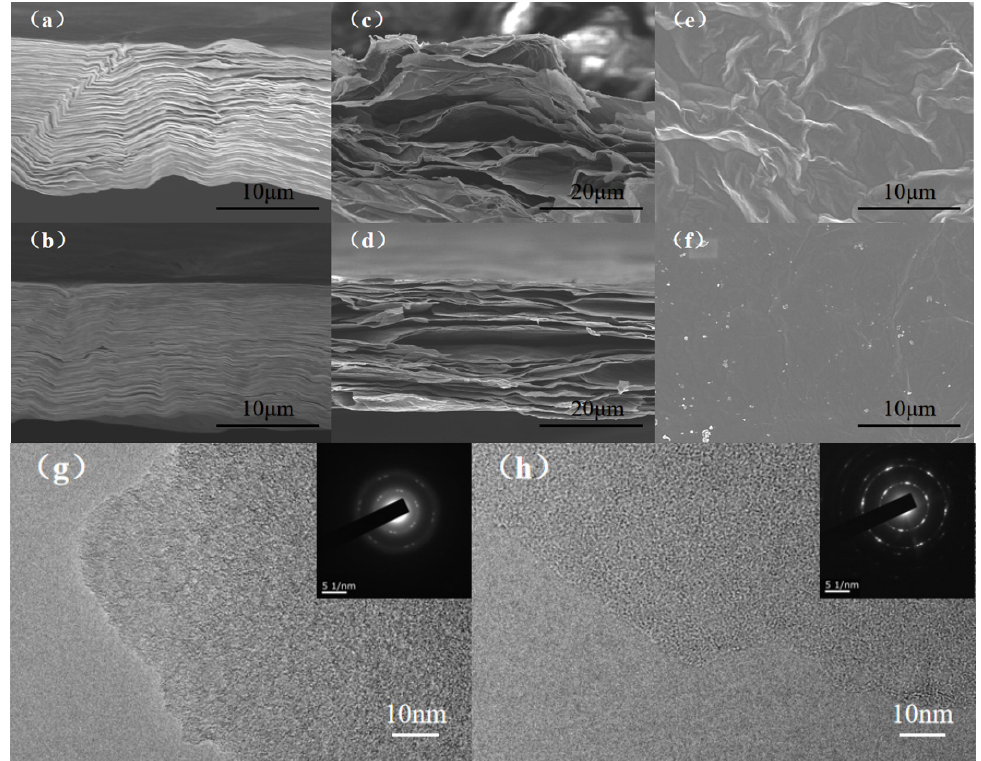
Figure 2. ( a , b ) Cross-sections of GO and GO/VC-15%; ( c , e ) cross-sections and surfaces of rGO; ( d , f ) rGO/VC-15% cross-sections and surfaces; ( g , h ) TEM characterization of rGO and rGO/VC-15%.